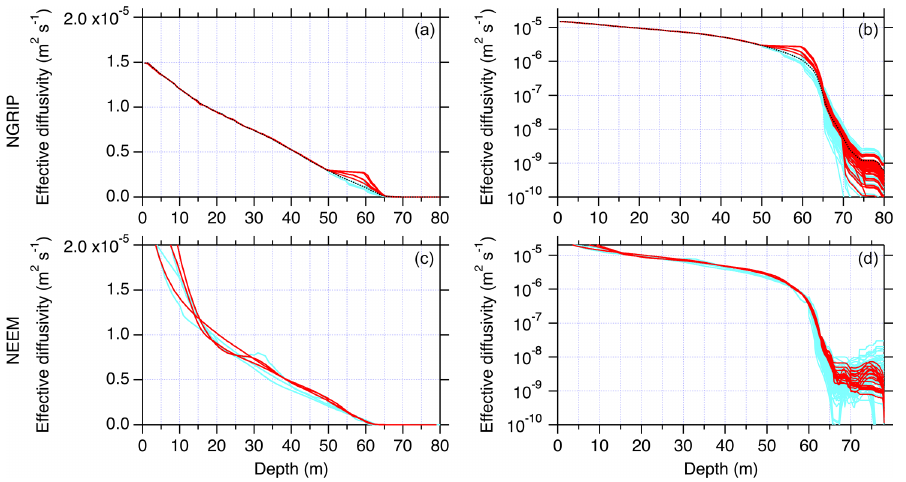
Figure 3. The 100 sets of effective diffusivity profiles of CO 2 in the NGRIP ( a, b , where panel a is on a linear scale and panel b is on a log scale) and NEEM firn (c, d) . The initial diffusivity profile (Ishijima et al., 2007) is shown by a black dotted line (NGRIP only) and modified diffusivity profiles are in colours. The diffusivity profiles whose corresponding mole fraction profiles have root mean square deviation (RMSD) values of < 1.0 are coloured red and the others light